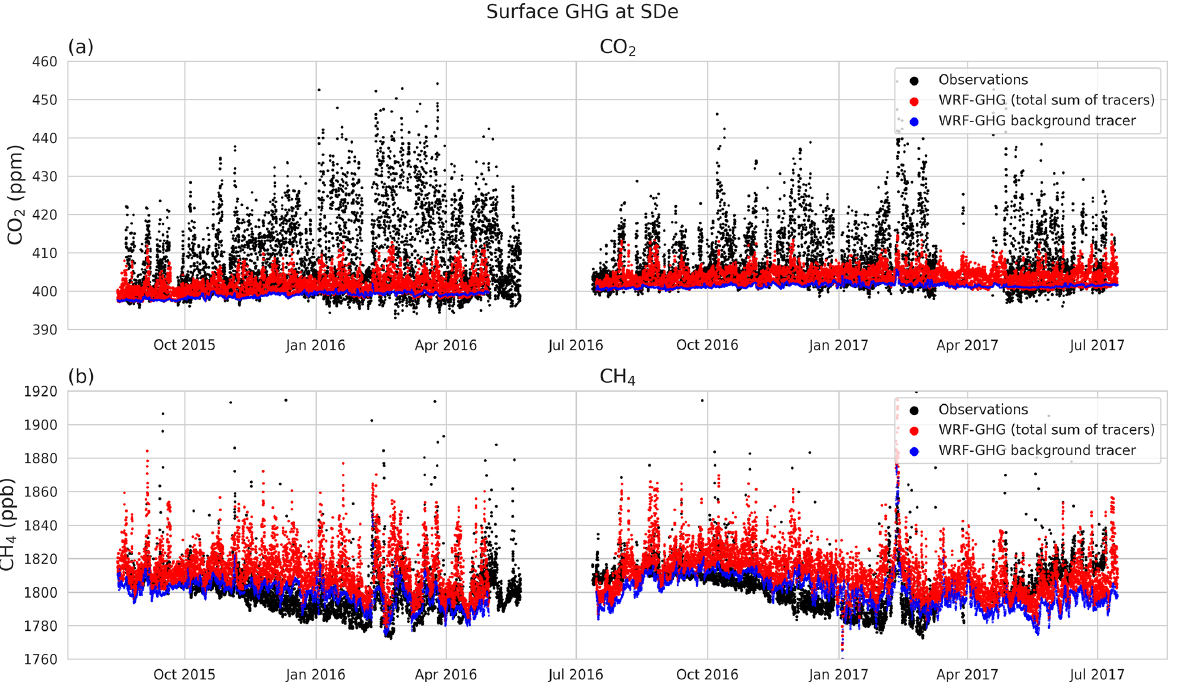
Figure C1. Time series of all observed (black) and modeled (red) in situ concentrations at SDe of (a) CO 2 and (b) CH 4 . The blue dots represent the modeled background